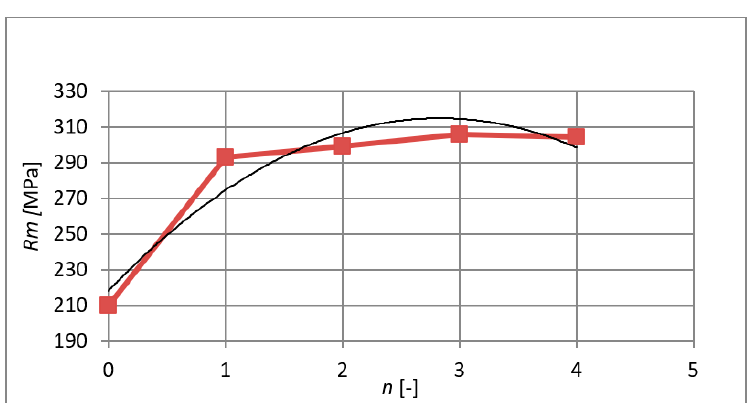
Figure 12. The course of the ultimate tensile strength after individual